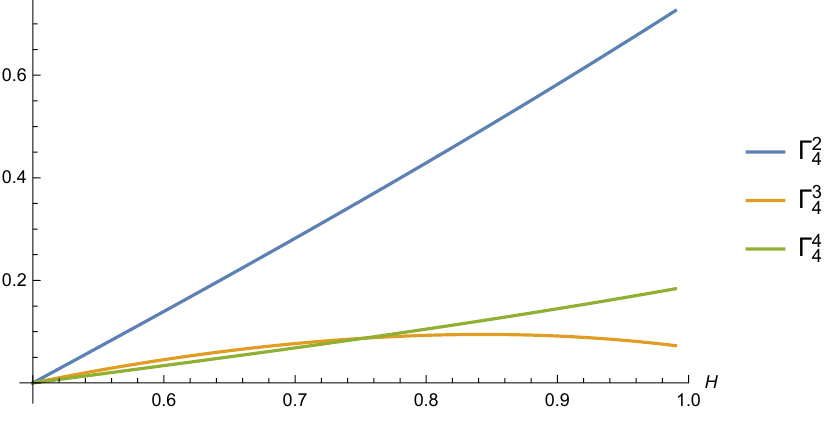
Figure 2. Case n = 4: Γ 2